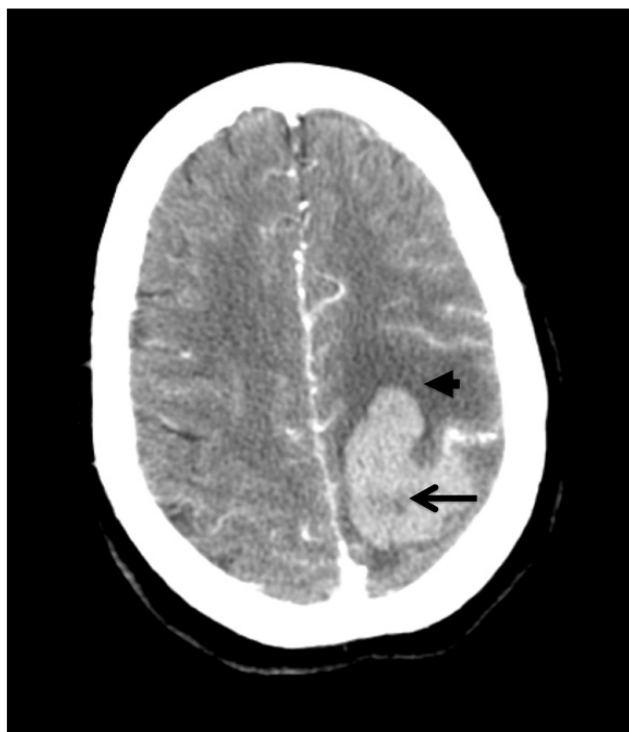
Image 2. Computed tomographic angiography of the patient’s brain demonstrating left middle cerebral artery mycotic aneurysm with intracerebral hemorrhage (black arrow) and surrounding vasogenic edema (arrow